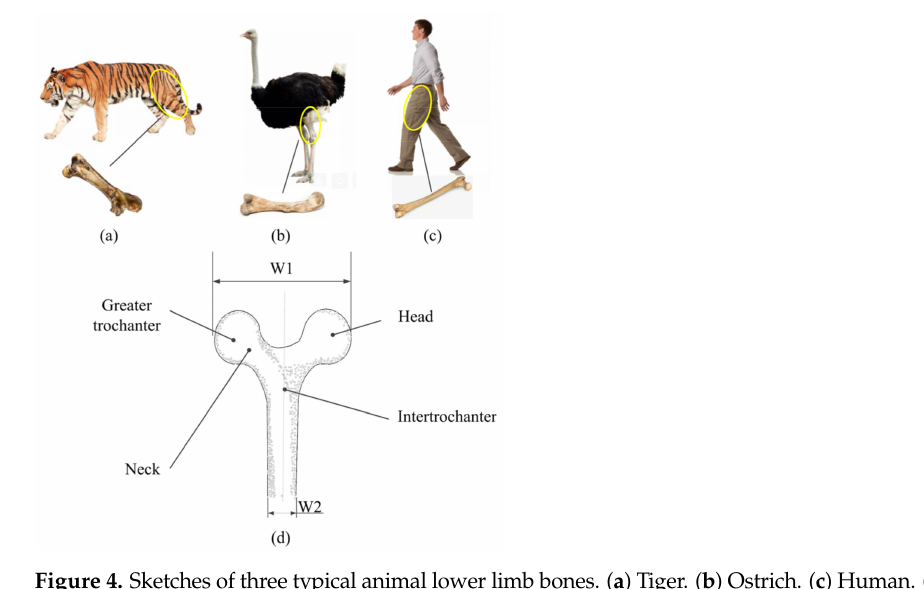
Figure 4. Sketches of three typical animal lower limb bones. ( a ) Tiger. ( b ) Ostrich. ( c ) Human. ( d ) Sketch of human